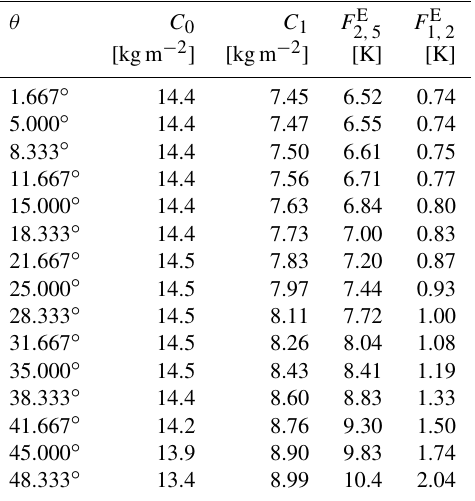
Table A3. Calibration parameters for the Arctic extended